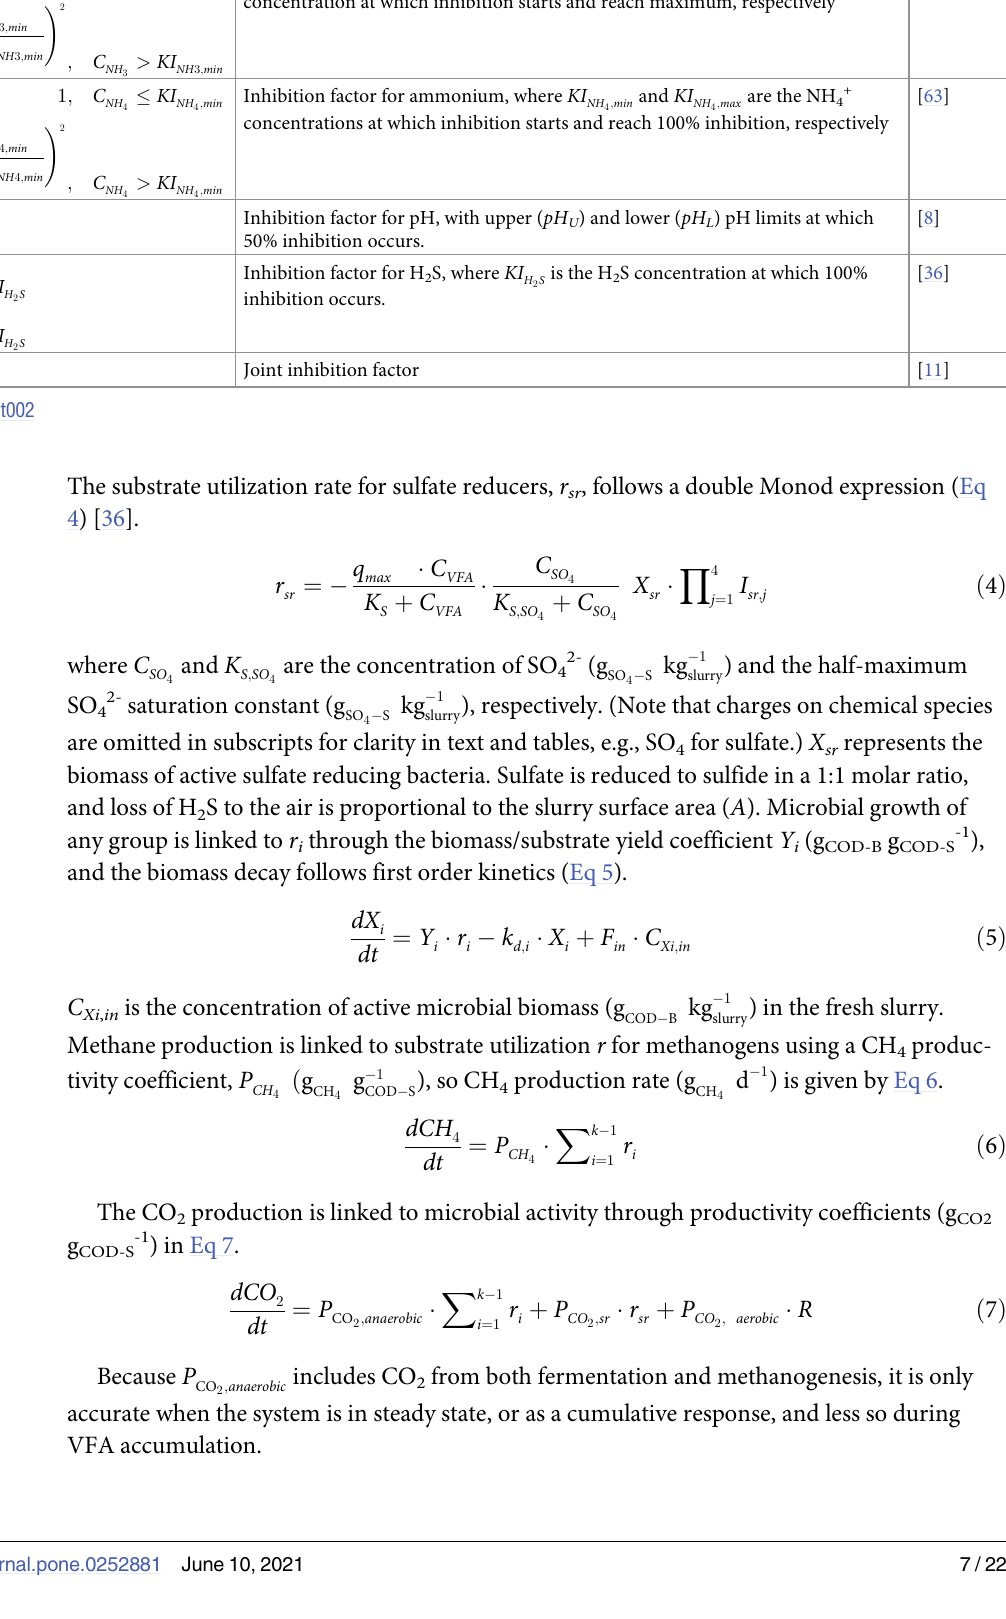
Table 2. Equations used for inhibition factors. Inhibition